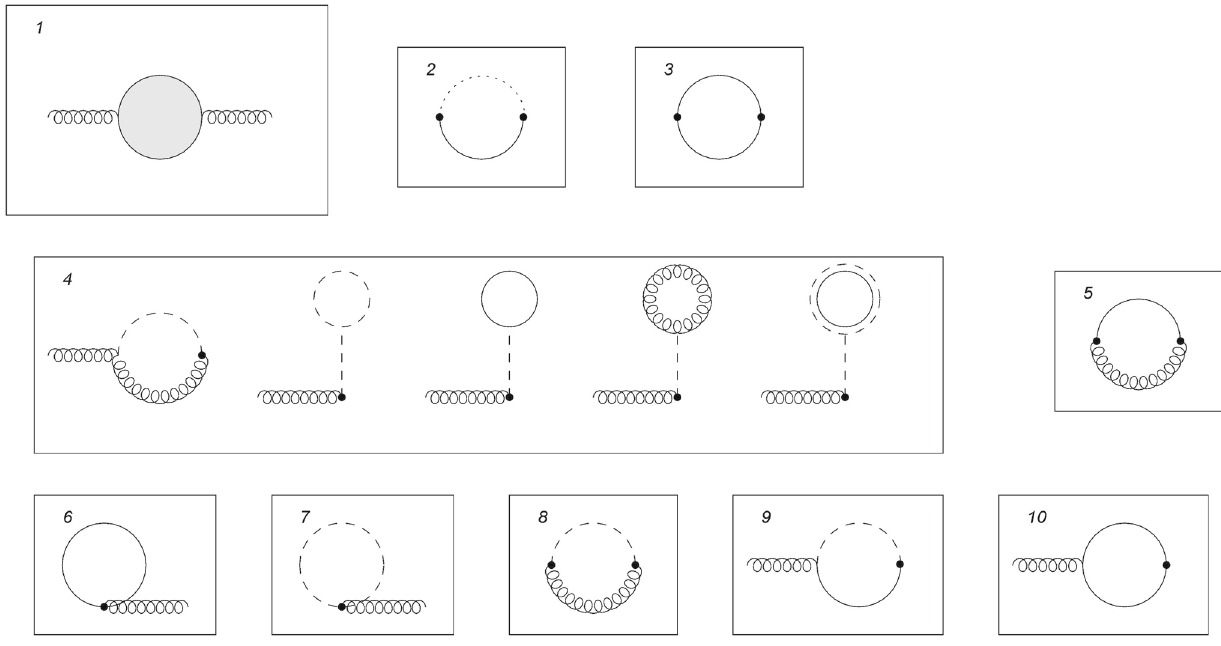
Fig. 11 One-loop contributions for the propagator (cid:2) R a μ ( x ) R a ν ( y ) (cid:3) in the unitary gauge. Curly lines represent the gauge field, dashed lines the Higgs field, solid lines the Goldstone boson and double lines the ghost field. The • indicates the insertion of a composite operator